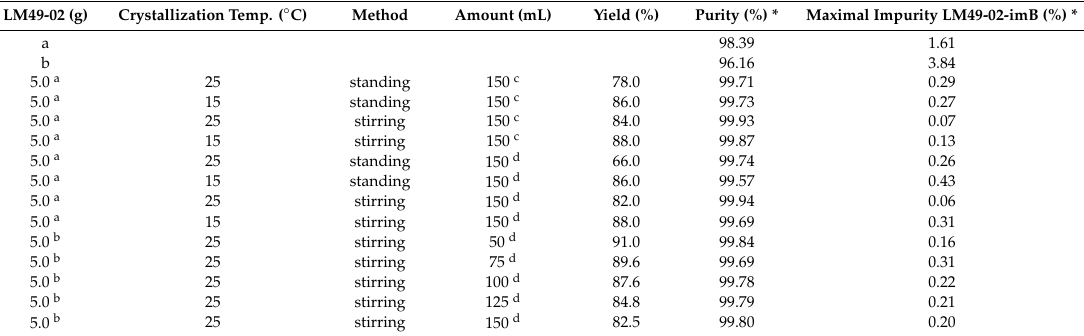
Table 4. Screening of purification conditions for LM49-02